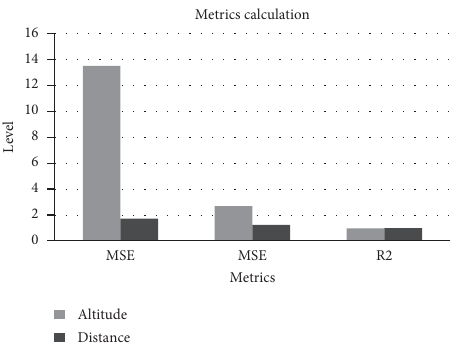
Figure 10: Graphical representation of ANN measurements.